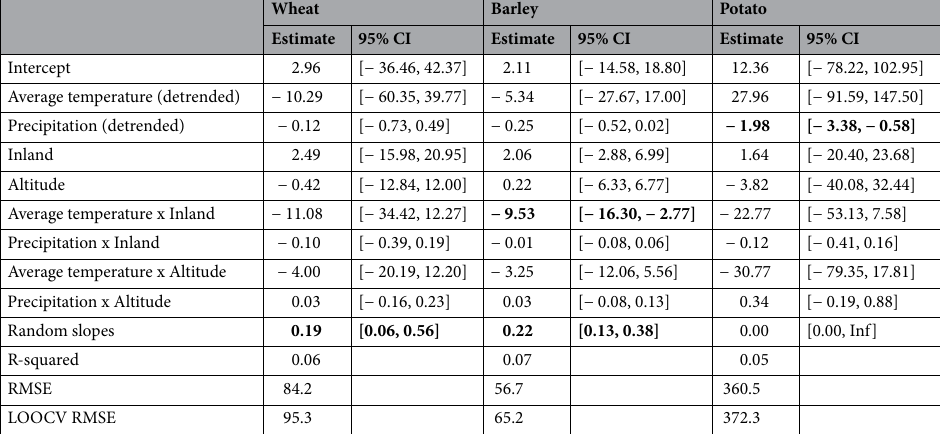
Table 1. Coefficients and 95% confidence intervals for linear mixed models with detrended yield of each crop as response. Values in bold indicate those estimates with confidence intervals that do not encompass zero. RMSE root mean squared error, LOOCV leave-one-out cross